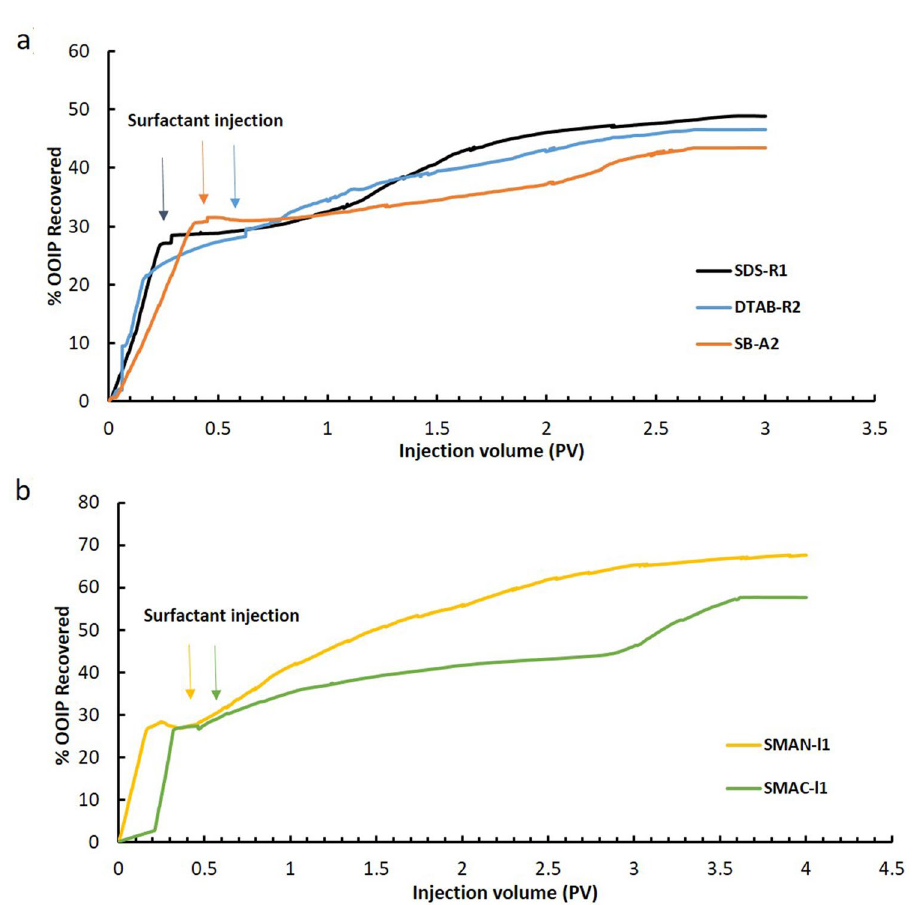
Figure 6. Oil production rate by injecting differently charged surfactants. ( a ) The injection of surfactants with IFT around 10 −1 mN/m. SDS-R1 in black line, DTAB-R2 in blue line and SB-A2 in orange line; ( b ) the injection of surfactants with IFT around 10 −3 mN/m. SMAN-I1 in yellow line, SMAC-I1 in green